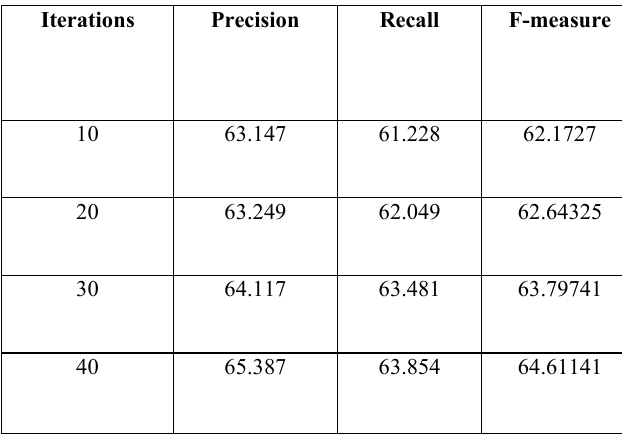
Table 1. Precision, Recall and F-Measure values for the proposed CS-ABC technique